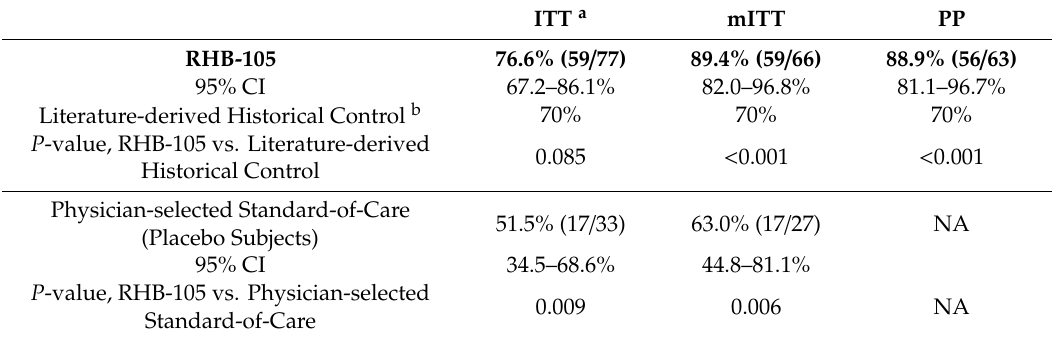
Table 2. Helicobacter pylori eradication rate: RHB-105 compared to literature-derived historical control and physician-selected